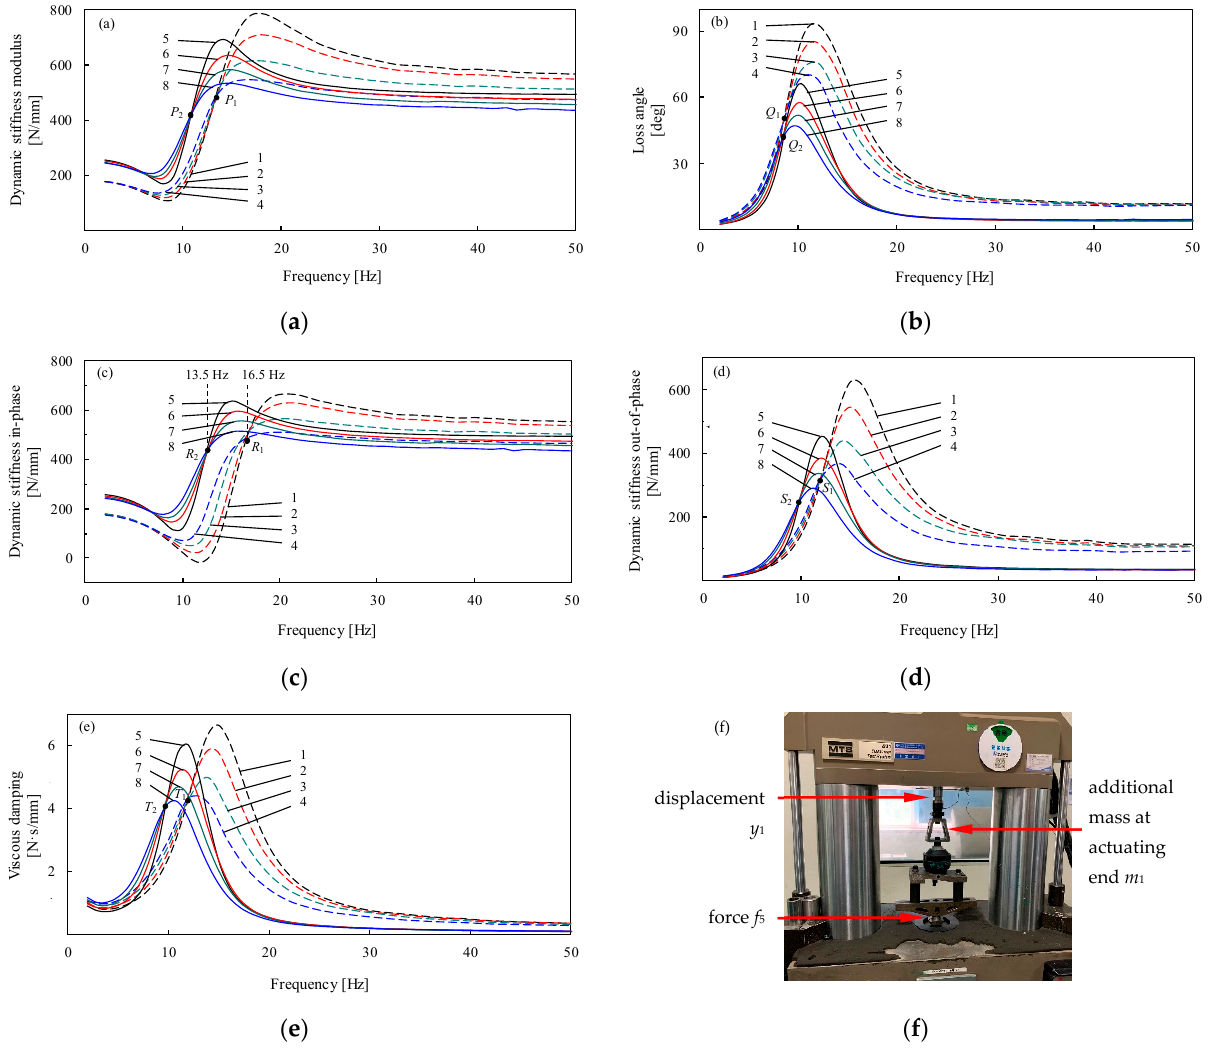
Figure 4. Experimental validation of the passive dynamic properties in mid-low-frequency bands and the fixed points P i , Q i , R i , S i , and T i ( i = 1,2) of a PHM-IT and a PHM-IT-DM. ( a ) Dynamic stiffness modulus; ( b ) loss angle; ( c ) dynamic stiffness in-phase; ( d ) dynamic stiffness out-of-phase; ( e ) viscous damping; ( f ) test rig. Key : The numbers 1–4 correspond to the PHM-IT under excitation amplitudes of Y 1 = 0.4, 0.6, 0.8, and 1.0 mm, respectively [5]; the numbers 5–8 correspond to the PHM-IT-DM under excitations of Y 1 = 0.4, 0.6, 0.8, and 1.0 mm, respectively.